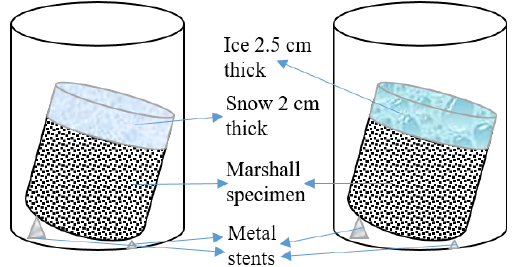
Figure 6. Diagram of single consumption of snow and ice melt test.